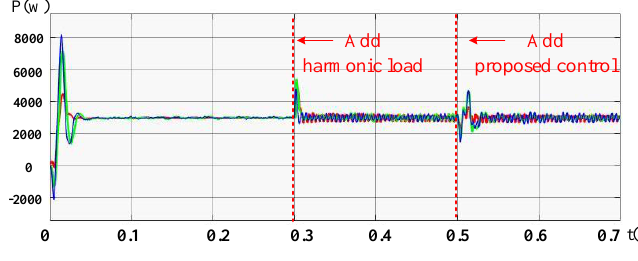
Figure 18. Power output of the three HCGIs.